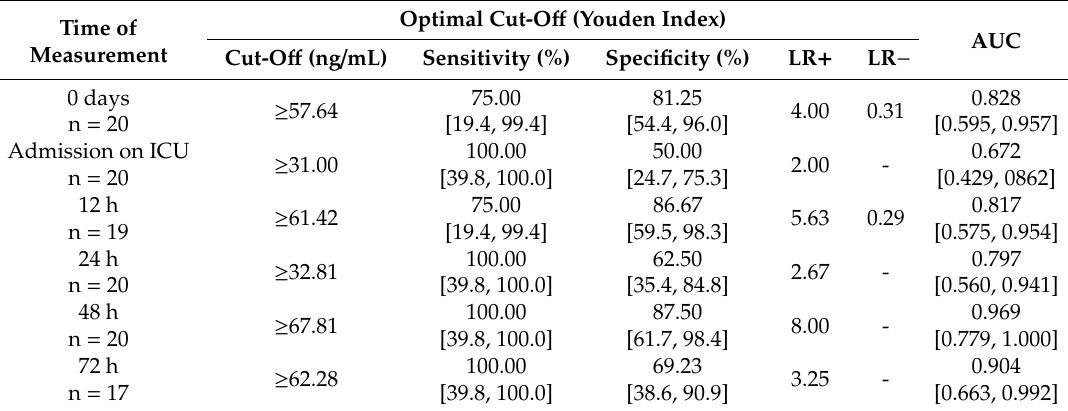
Table 2. RNASE to predict AKI (stadium = 0) vs. AKI (stadium =